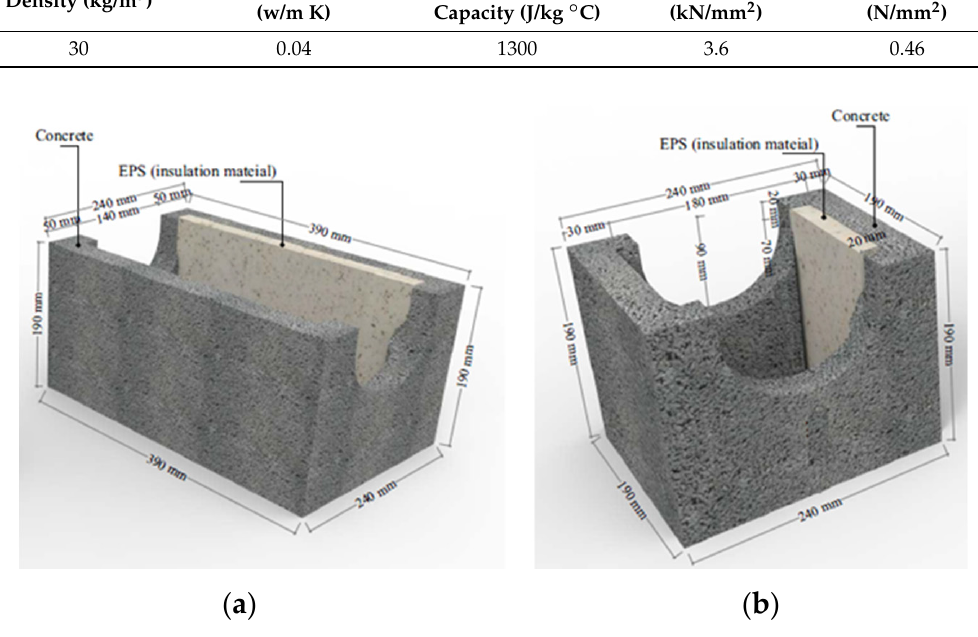
Figure 2. Self-insulating concrete masonry unit (SCMU) configurations: ( a ) block; and ( b ) half-block units [15]. EPS: expanded polystyrene. Table 2. Average compressive strength of masonry materials (N/mm 2 ).